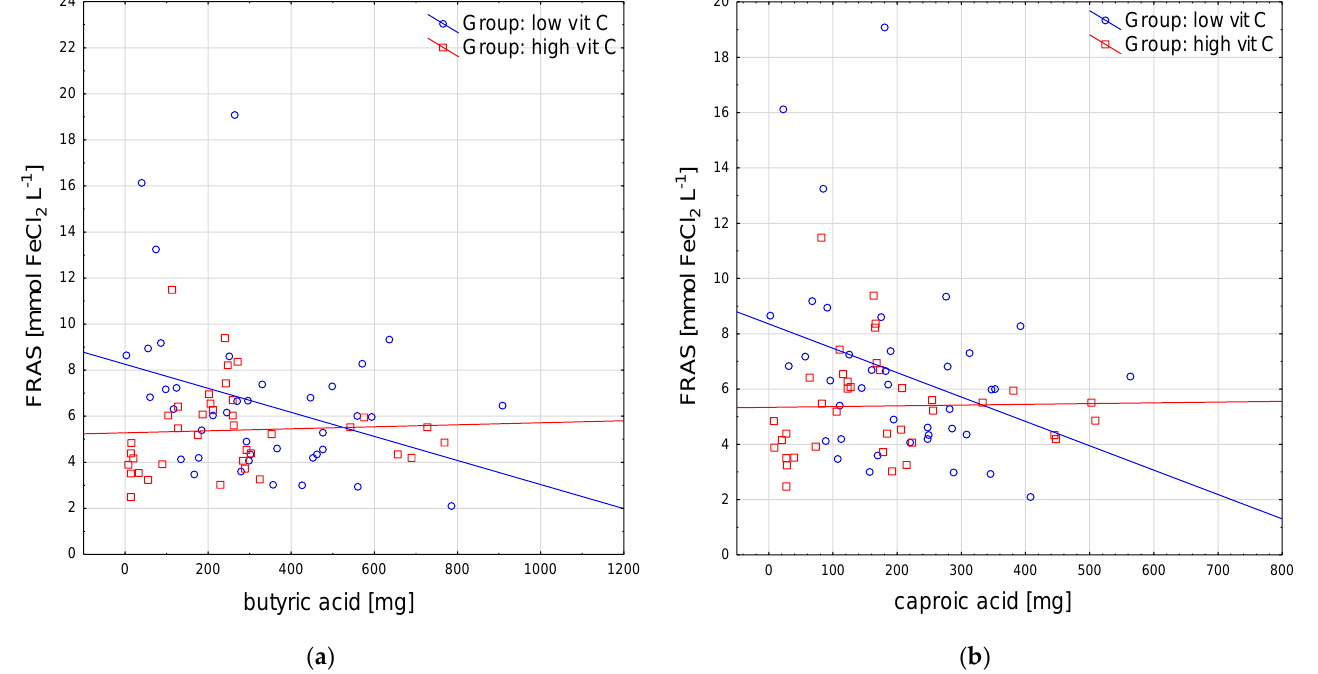
Figure 2. Selected correlations of salivary antioxidant parameters with short-chain fatty acids: ( a ) FRAS and butyric acid; ( b ) FRAS and caproic acid. FRAS, ferric reducing ability of saliva. Of the few negative correlations with AA intake for the whole study group, in the group with a low Vitamin C intake, only the correlation with DPPHS (rho = − 0.34) was observed, and in the group with a high Vitamin C intake, only the correlation with Nu-FRAS was noted (rho = − 0.41) ( p < 0.05 for